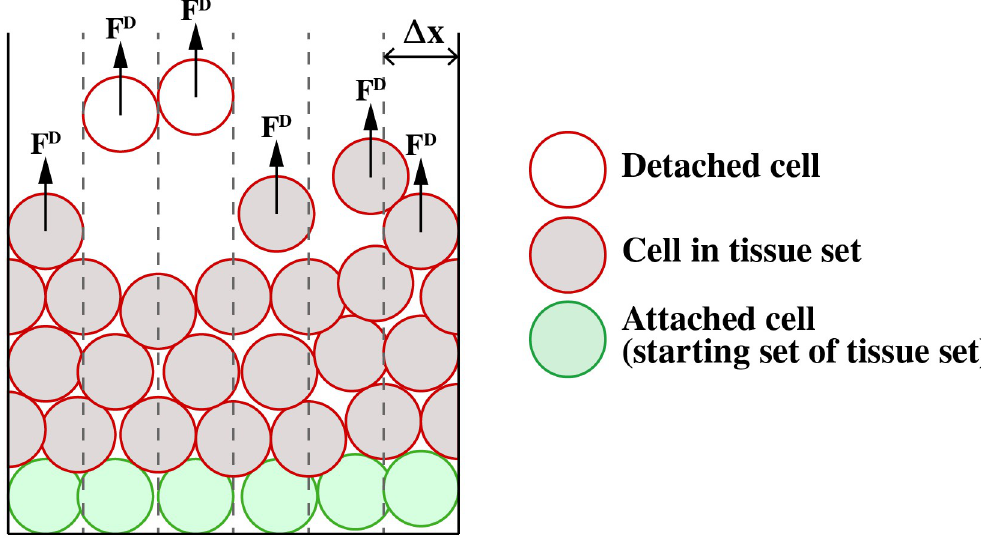
Fig 9. The desquamation model. Surface cells experience a vertical desquamation force. Once they detach from the tissue they get removed. Detachment is defined by determining the connected tissue set, starting with the set of attached cells.